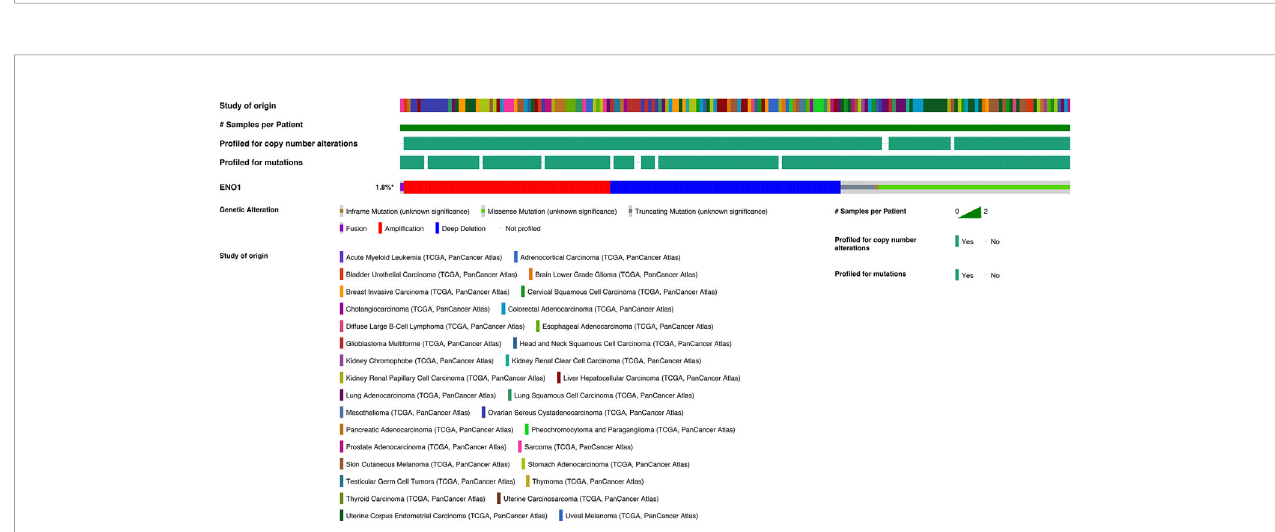
FIGURE 6 | Chart plots of genetic alteration of ENO1 in The Cancer Genome Atlas patients. A total of 1.8% ENO1 was altered including inframe mutation, missense mutation, truncating mutation, fusion, ampli fi cation and deep deletion. The detailed information is